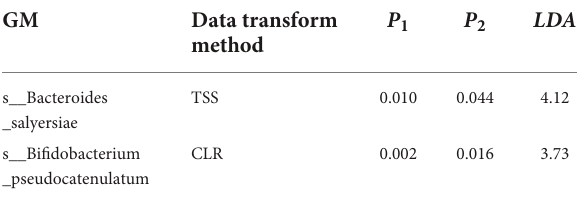
TABLE 7 Gut microbiota that showed replicated results in the American